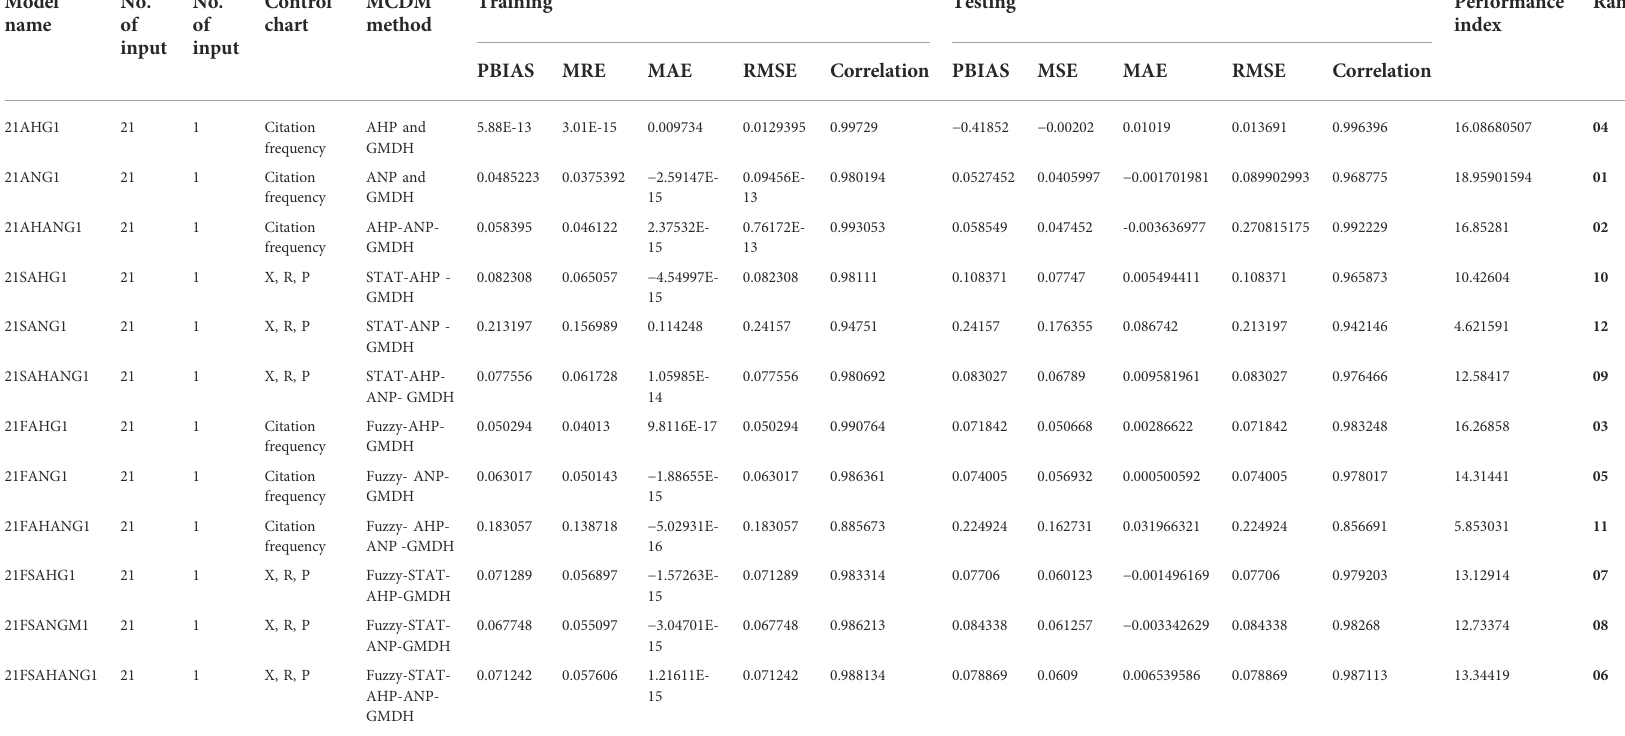
TABLE 5 Table results of the 12 models developed for prediction of ef fi ciency of wave energy farms. Model